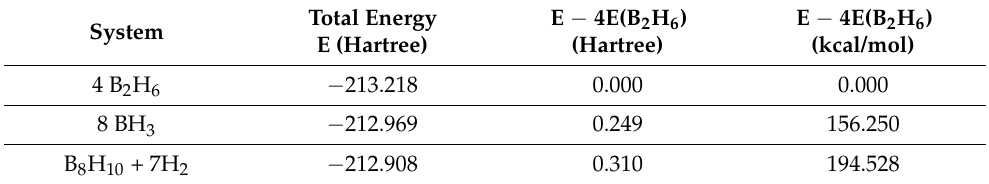
Table 2. B 2 H 6 , 8 BH 3 , and B 8 H 10 + 7H 2 . All the systems have 8 boron and 24 hydrogen atoms.